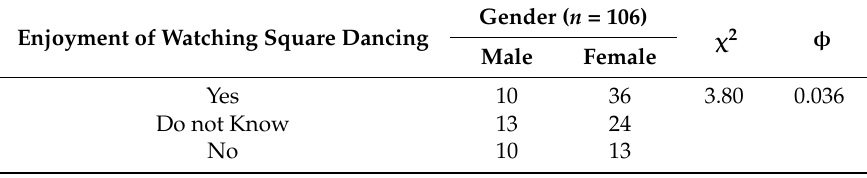
p = 0.1495, df = 2. Table 9. Chi Squared Test comparing gender to unpleasantness of square dance music. Gender ( n = 106) Unpleasantness of Square Dancing Music χ 2 φ Male Female Yes 8